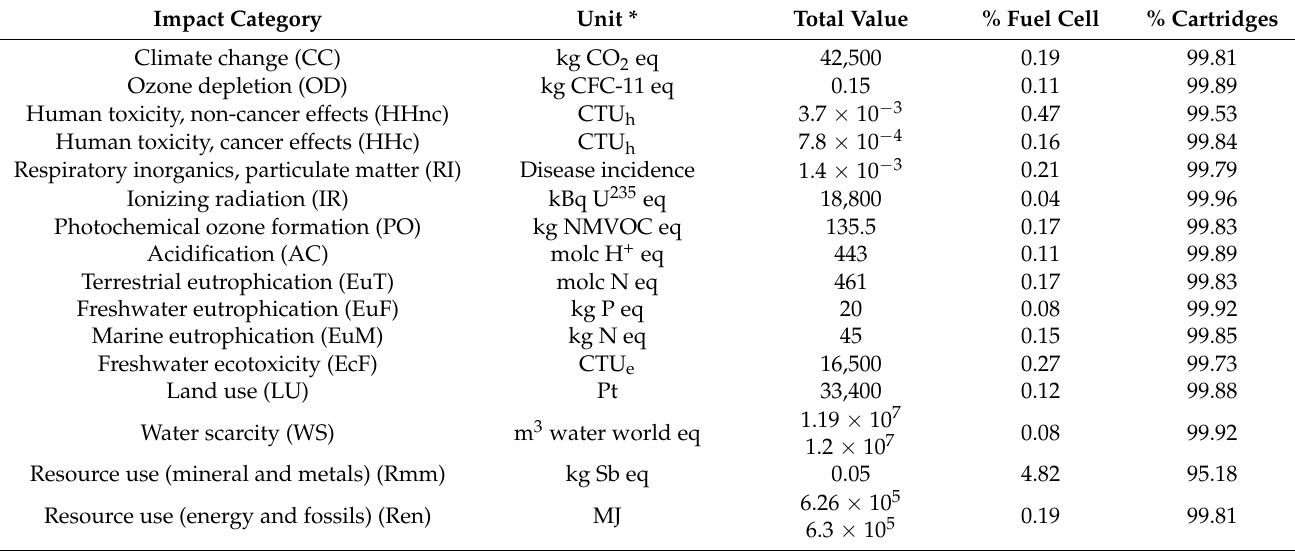
Table 5. EF results of the manufacturing and useful life of the fuel cell and the percentage contributions of the fuel cell infrastructure versus hydrogen